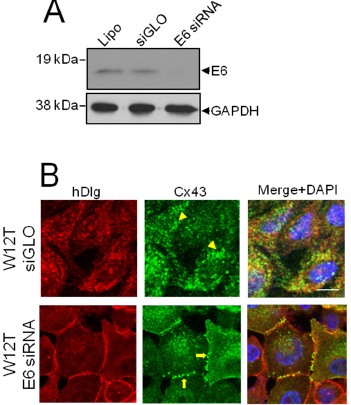
Figure 3. E6 restricts Cx43 trafficking to the plasma membrane in W12T cells. ( A ) Western blot showing depletion of E6 following siRNA treatment of W12T cells. Lipo, mock transfected cells treated with lipofectamine. siGLO, cells transfected with control siRNA. E6 siRNA, cells transfected with HPV16 E6 siRNA; ( B ) Confocal immunofluorescence microscopy imaging showing the location of hDlg (red) and Cx43 (green) in control transfected W12T cells or in W12T cells transfected with siRNA against E6. Arrowheads indicate cytoplasmic Cx43 while arrows indicate Cx43 located in gap junctions plaques on the cell membrane. Nuclei are stained with DAPI. Bar = 10 μ M.